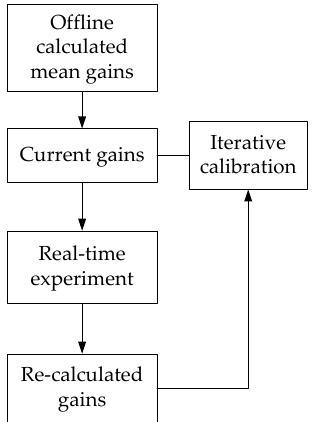
Figure 15. Muscle activation prediction results using different reflex gains. The gains are calculated from different lengths of data. The dotted line is the measured muscle activation. The results show that the prediction results are not acceptable if the length of the data is too short.